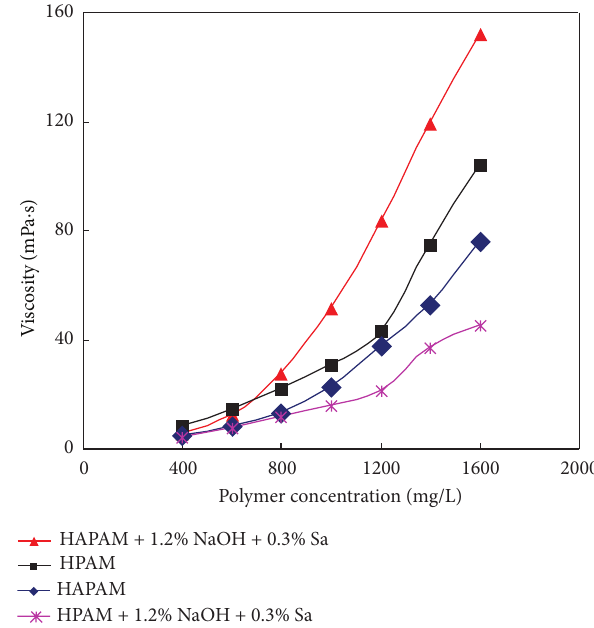
Figure 2: Viscosity-concentration curves of four flooding